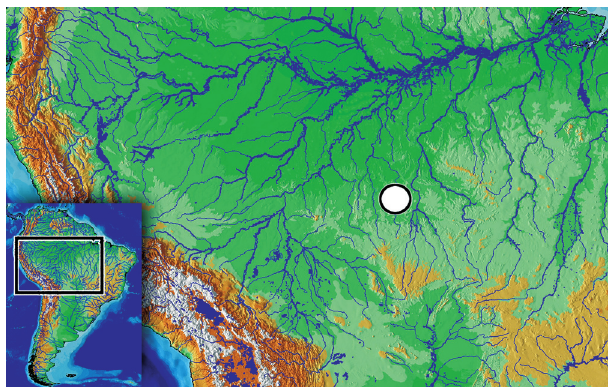
Fig. 3. Rio Aripuanã area showing the collection localities (circle) of Trachycorystes menezesi